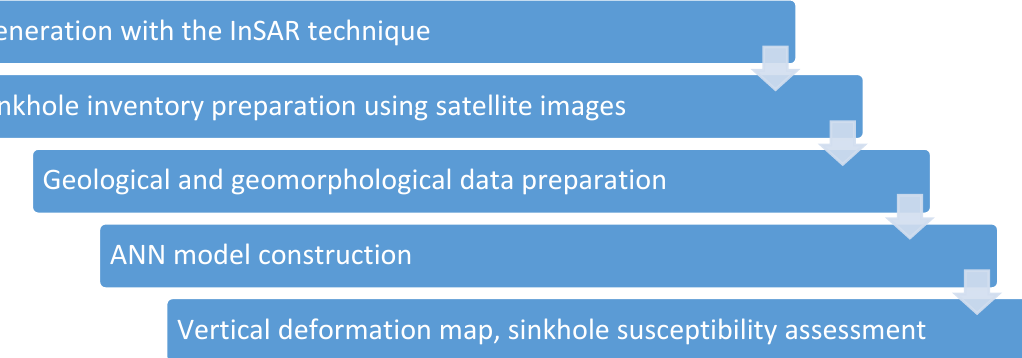
Figure 5. The main methodological workflow of this study.